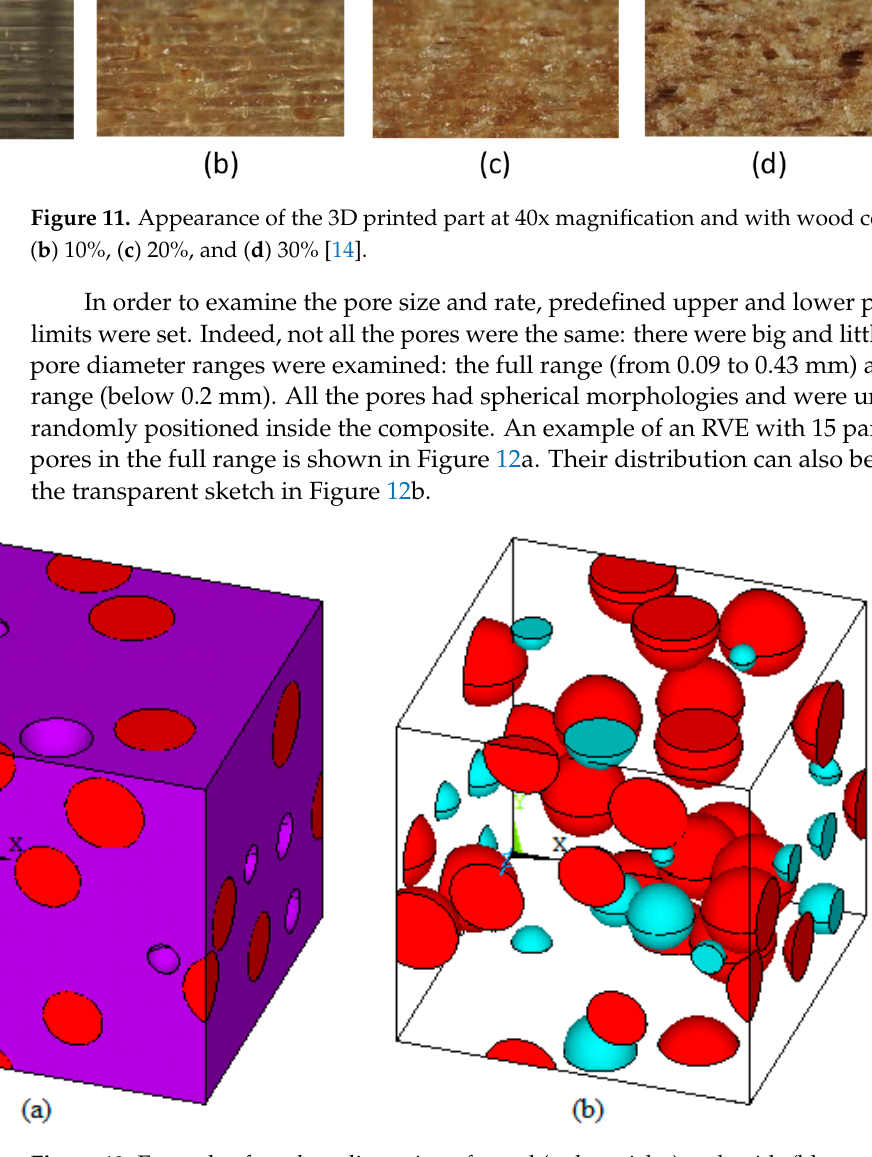
Figure 12. Example of random dispersion of wood (red particles) and voids (blue pores) inside the RVE—( a ) solid model, ( b ) transparent model.